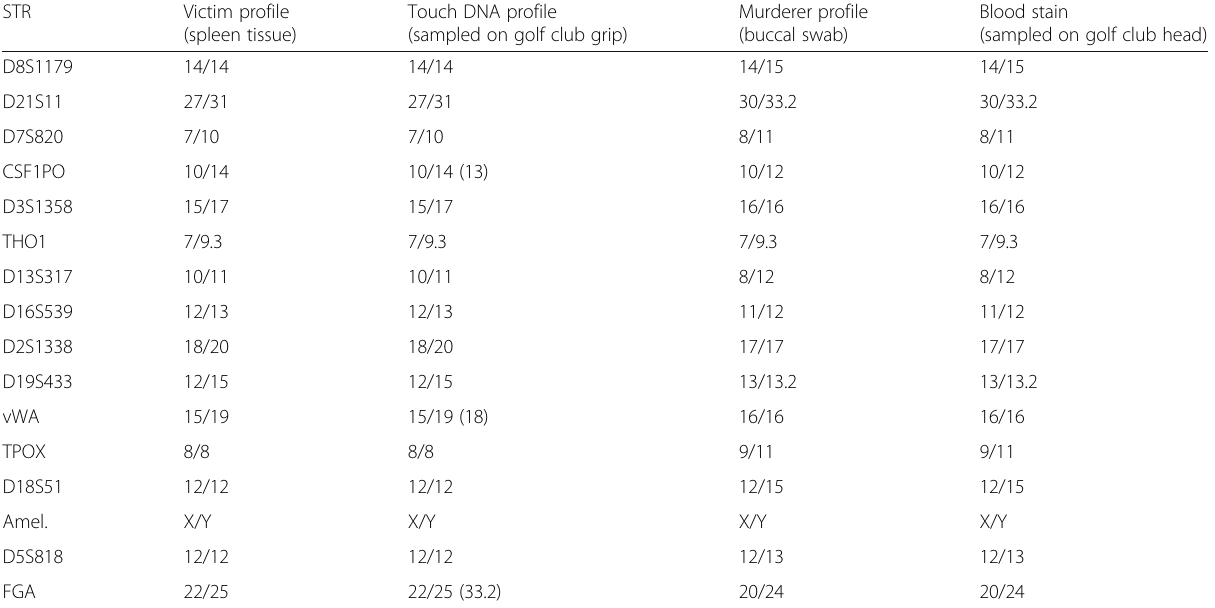
Table 1 STRs obtained analyzing all samples. The extra-peaks are indicated in red STR Victim profile (spleen